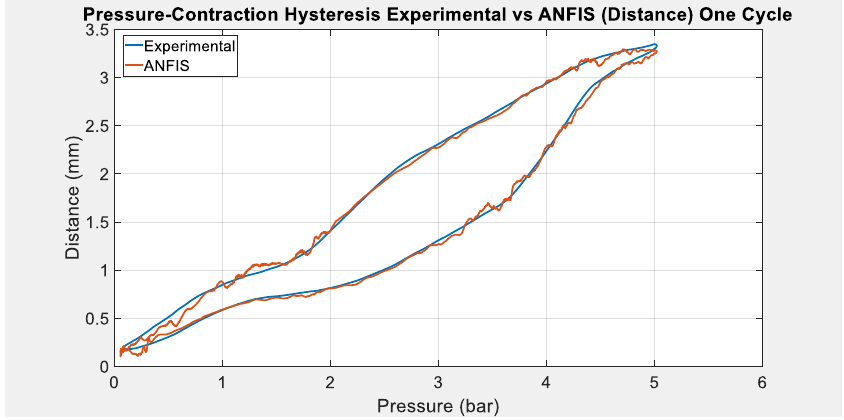
Figure 10. Experimental vs. ANFIS pressure-contraction using the two-input technique for the ANFIS.